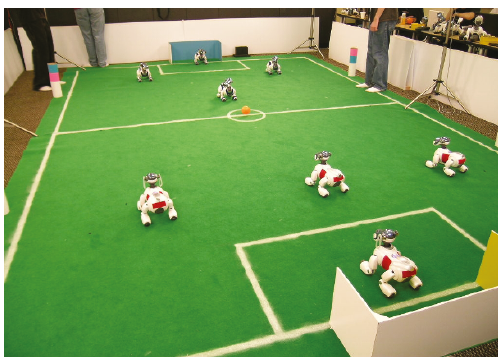
Figure 1: Sony AIBO robots preparing to play robot soccer at a RoboCup